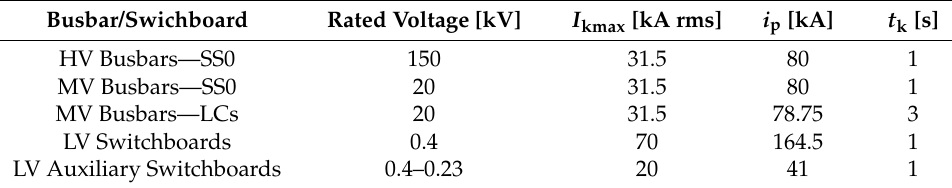
Table 13. Sizing values of busbars and switchboards.